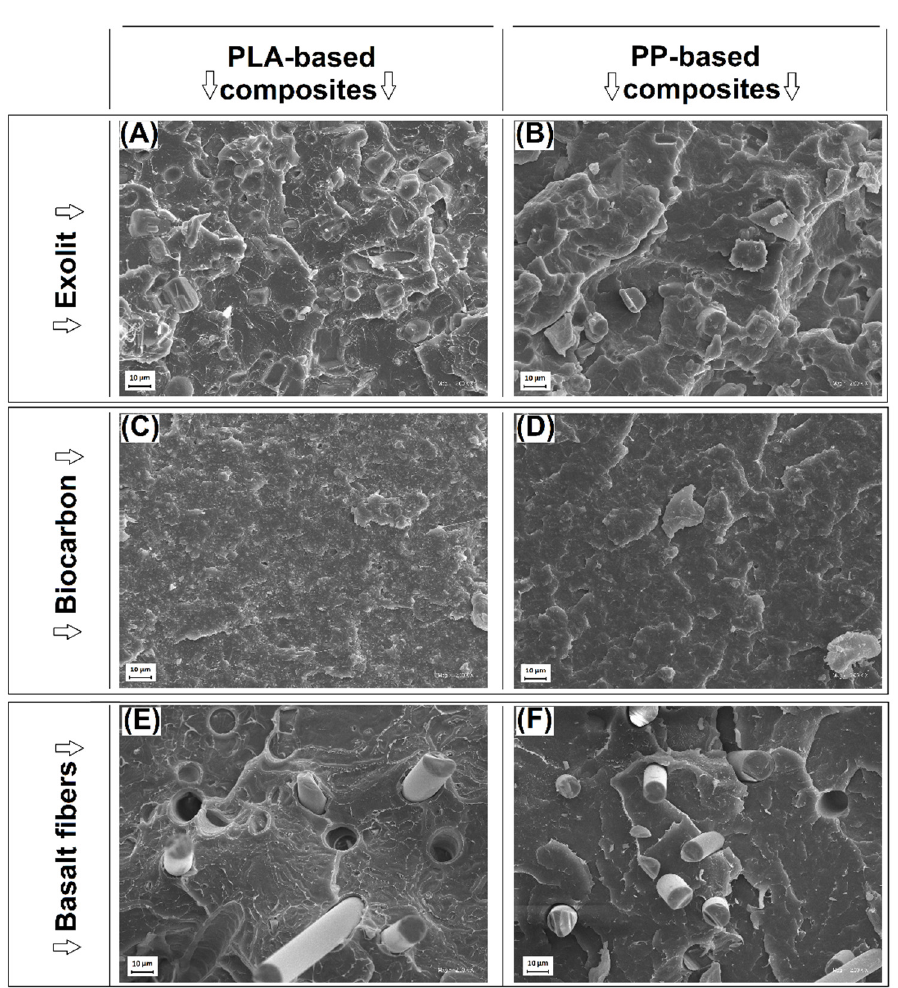
Figure 1. The structure appearance of the ( A , B ) EX-based composites, ( C , D ) BC-based, and ( E , F ) BF-based materials.